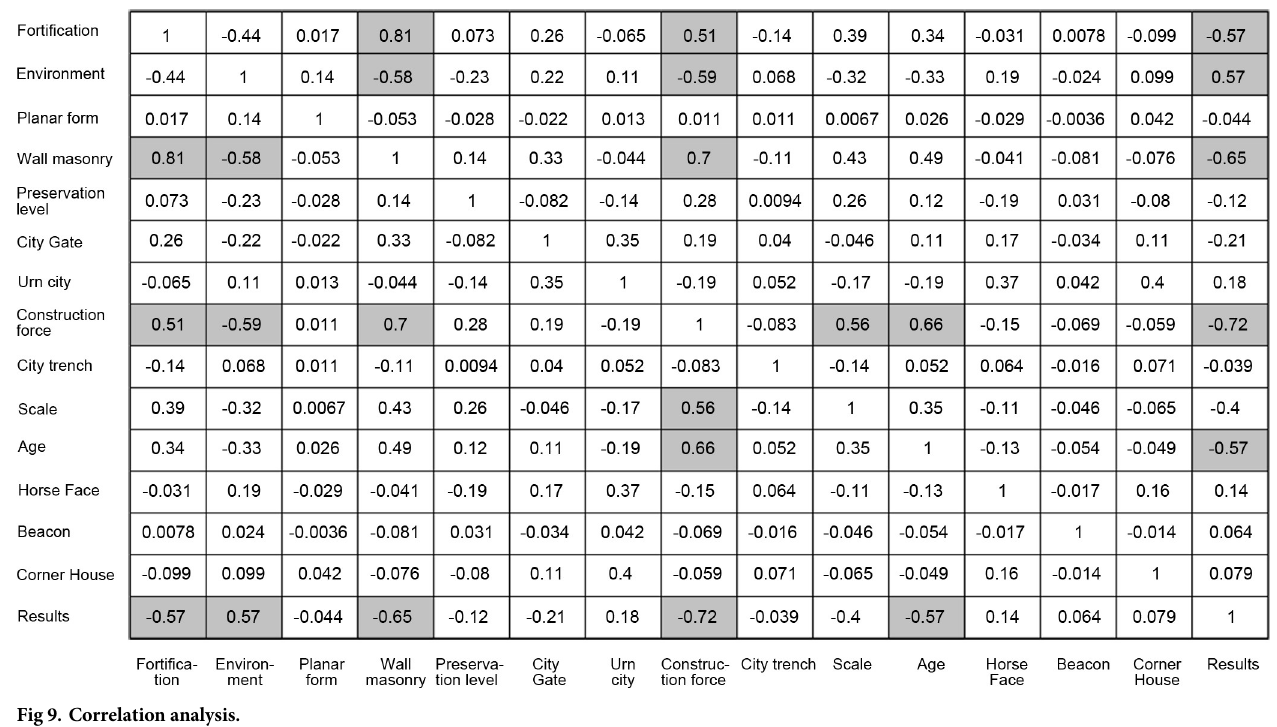
results of the distribution of the four cluster systems can support this view. Government-built fort-type settlements such as the Song-Xia War Border Military Fort Cluster and the Ming Great Wall Military Defense System Fort Cluster are located in northern Shaanxi, which is the border area during Song and Ming dynasties. While civilian fort-type settlements such as the